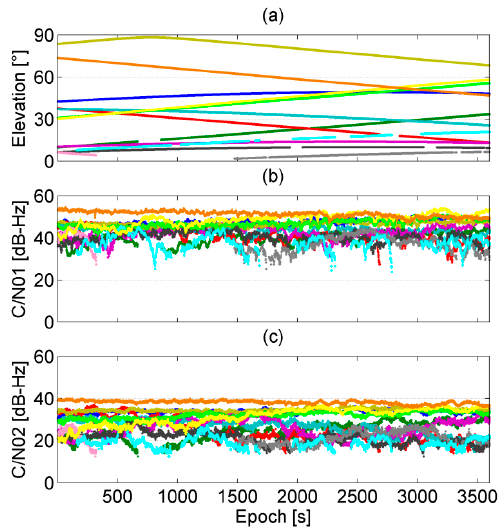
Figure 14. ( a ) Elevations of used satellites; ( b ) C/N0 of C1 (CN01) of used satellites; and ( c ) C/N0 of P2 (CN02) of used satellites. Each color denotes one satellite calculated from dataset no. 2.